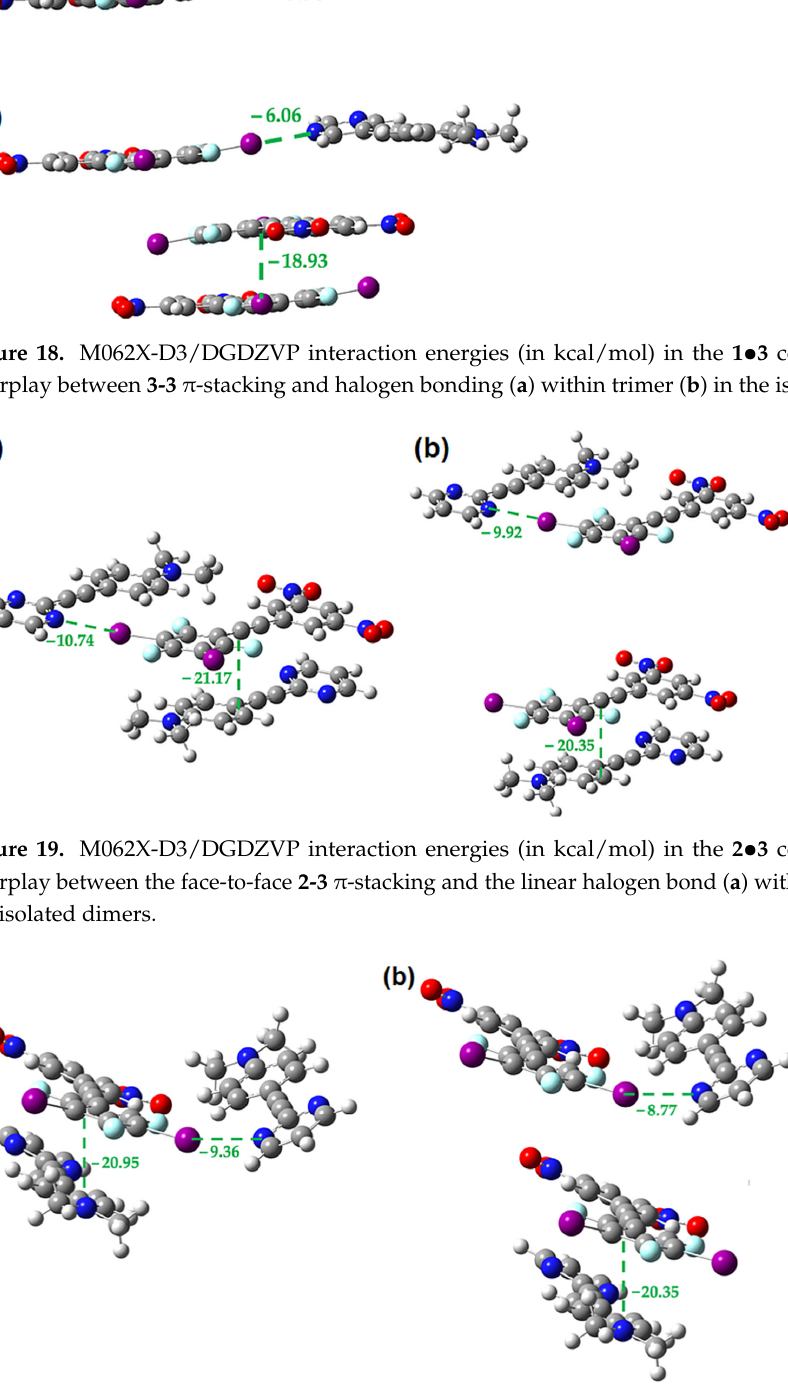
Figure 17. M062X-D3/DGDZVP interaction energies (in kcal/mol) in the 1•3 cocrystal for the inter- play between 1-1 π -stacking and halogen bonding ( a ) within trimer ( b ) in the isolated dimers.